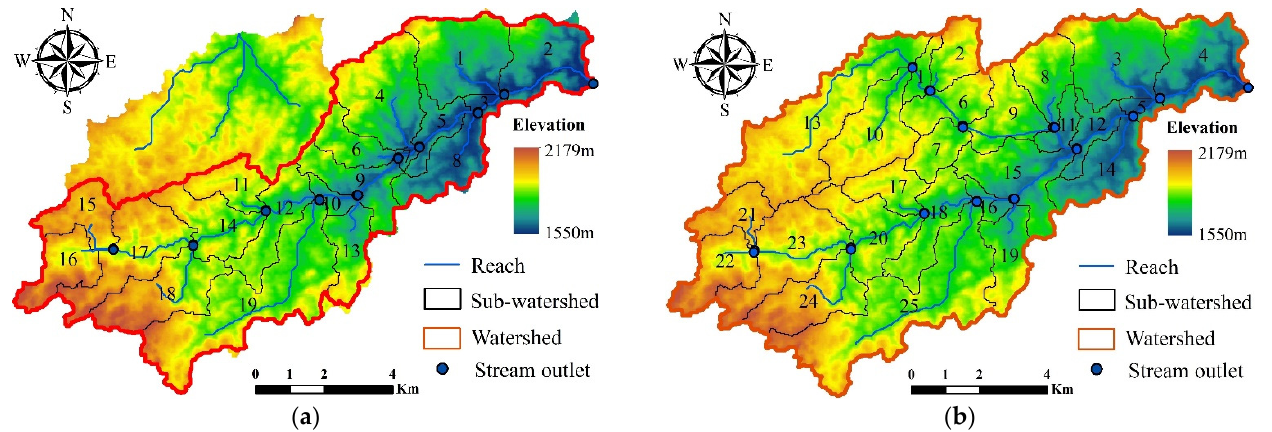
Figure 6. ( a ) Watershed and sub-watersheds identified based on original DEM data; ( b ) Watershed and sub-watersheds identified based on modified DEM data.